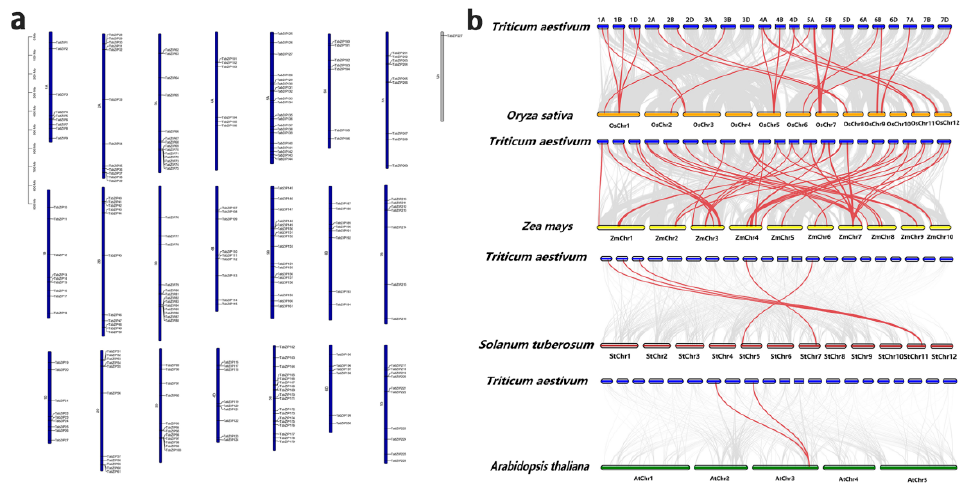
Figure 3. Collinearity analysis of TabZIP gene family. ( a ) Chromosome locations of TabZIP genes. The chromosome number is on the left side of each chromosome. The scale on the left represents chromosome length. ( b ) Synteny analysis of TabZIP genes between Triticum aestivum and four representative plant species. Gray lines indicate the collinear bars within the Triticum aestivum and other plant genomes, whereas the red lines highlight the syntenic TabZIP gene pairs.